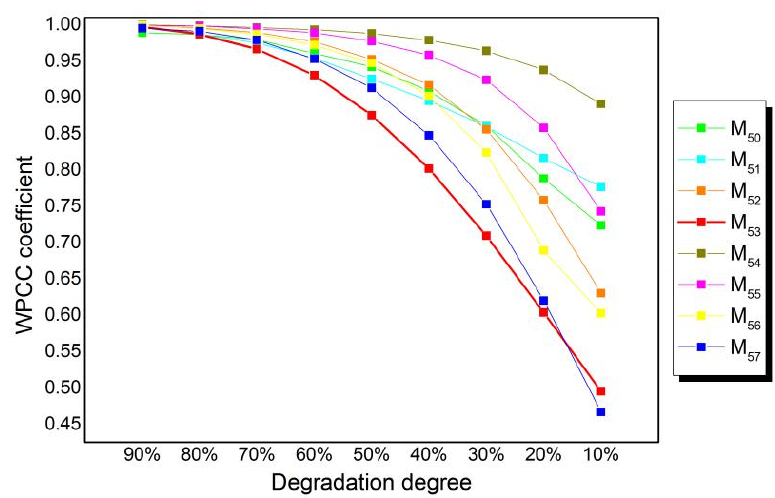
Figure 5. WPCC Coe ffi cients for each degradation degree. Figure 5. WPCC Coefficients for each degradation degree.